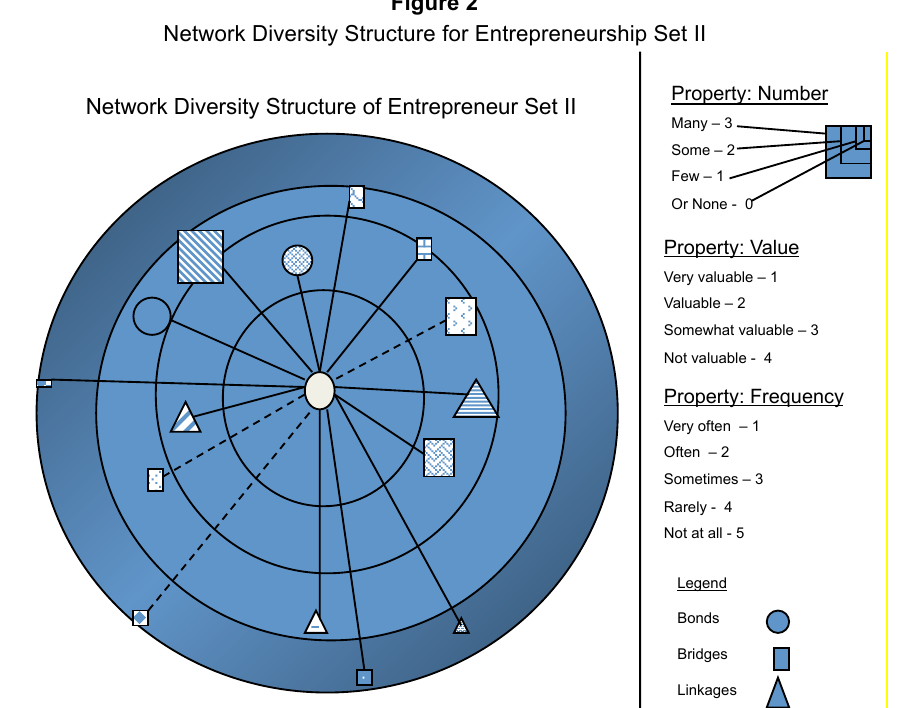
Network Diversity Structure for Entrepreneurship Set